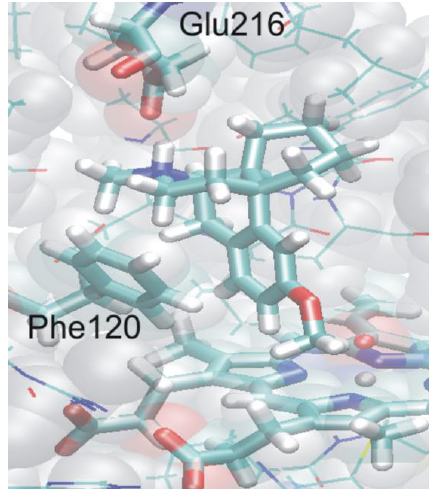
Figure 16. Active site of P450 2D6 with dextromethorphan. The movement of dextromethorphan in the active site is hindered by its salt bridge to Glu216 and by the steric hindrance of the bulky amino acid